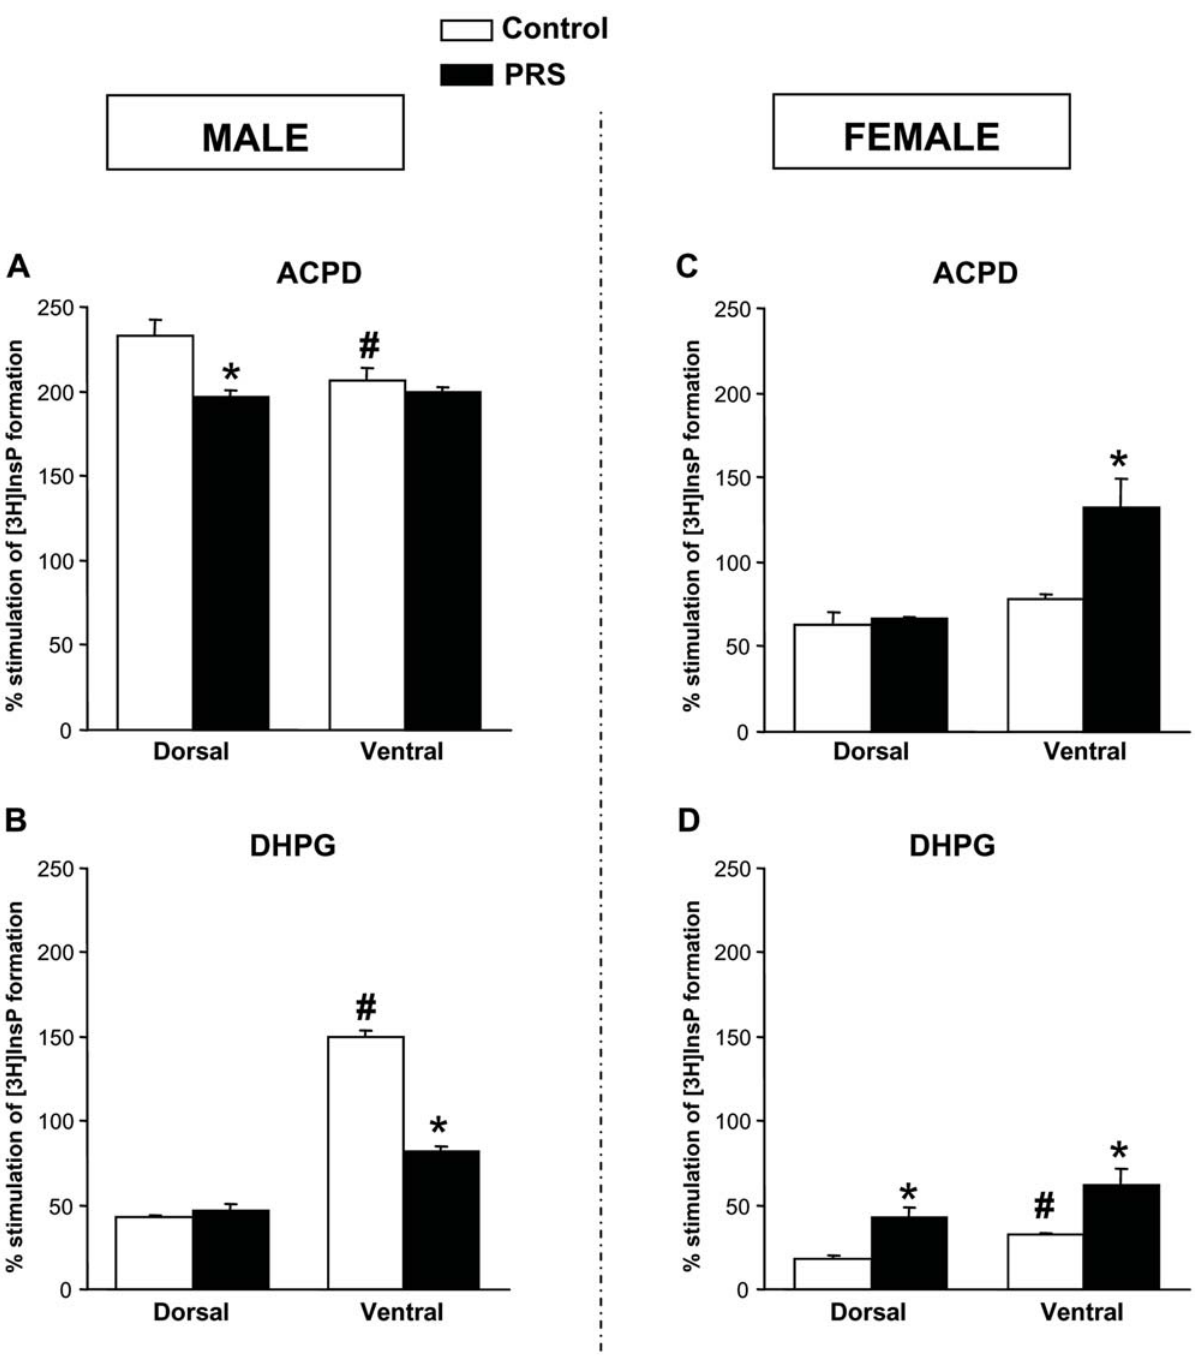
Figure 7. Gender effect in the effect of PRS on 1S,3R-ACPD or DHPG-stimulated PI hydrolysis in slices prepared from the dorsal or the ventral hippocampus. Data obtained from slices of male and female rat hippocampi are shown in (A,C) and (B,D) , respectively. Values are expressed as means 6 S.E.M. of 6–9 measurements from 2–3 independent experiments. ANOVA for group 6 region: F (1,8) =4.97, p , 0.05 for 1S,3R-ACPD and F (1,8) =128.79, p , 0.05 for DHPG in males; F (1,8) =7.54, p , 0.05 for 1S,3R-ACPD in females). * p , 0.05 Newman-Keul’s test post-hoc for PRS vs. control animals; # p , 0.05 ventral vs. dorsal hippocampus (n=5 rats per group). doi:10.1371/journal.pone.0002170.g007 stress paradigm used (one daily stress session of 30 min vs. three behavioral outcome may have interesting preclinical and clinical daily stress sessions of 45 min) may account for the differences in implications, and is worth investigating. The contrary effects of the EPM data obtained by Zagron and Weinstock [6] and our PRS on anxiety in male and female rats, at least under our stress own. The possibility that the frequency and duration of prenatal paradigm, are supported by the opposite changes in mGlu1/5 stress affects not only the extent but also the direction of the receptor function found in the ventral hippocampus, a region that